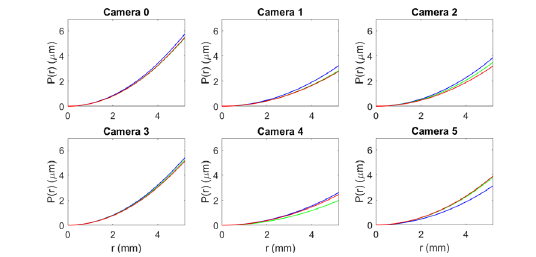
Figure 11. Case 1 Ladybug5 decentring lens distortion profiles.